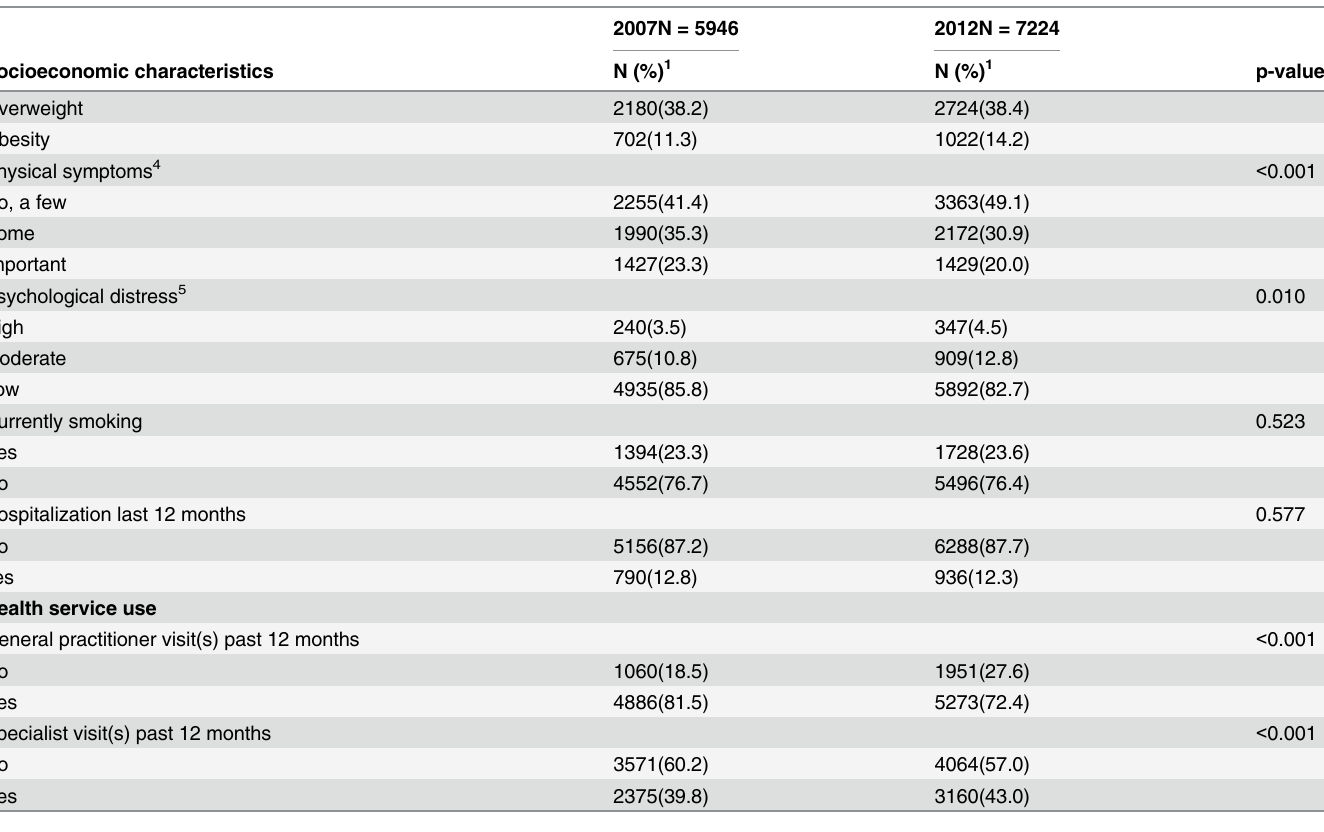
Prevalence and trends of CRC screening